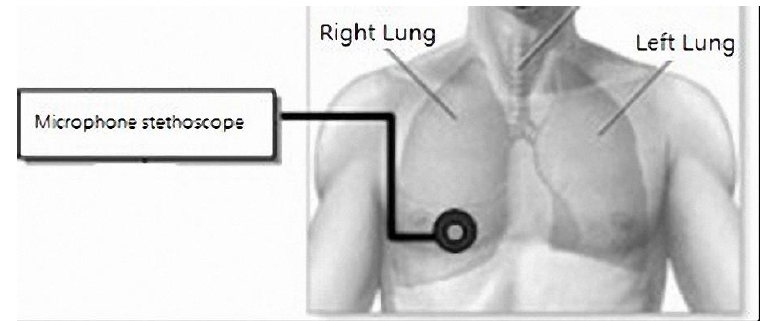
Figure 19. Lung auscultation position.